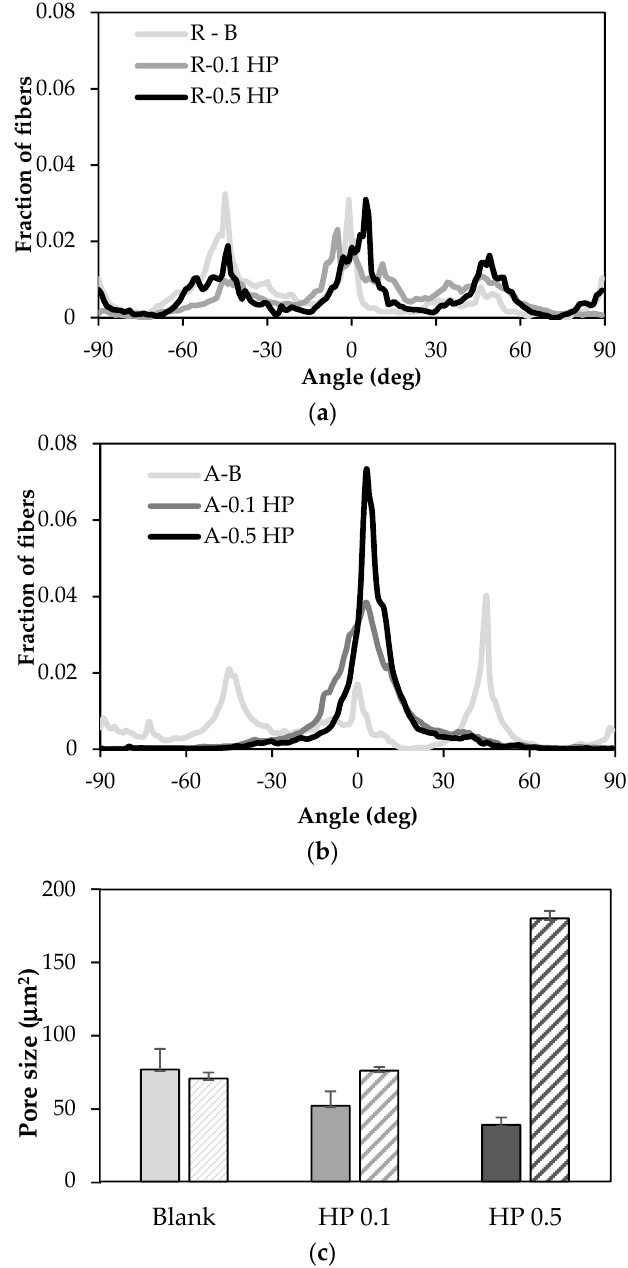
Figure 3. Degree of fiber orientation of blank (light grey), 0.1% HP (grey), and 0.5% HP (dark grey) scaffolds in the random ( a ) and aligned tubular ( b ) structure. The mean pore area ( μ m 2 ) is reported in subfigure ( c ) (full color: random structure; shaded: aligned tubular). ANOVA one − way; Scheffé test ( p ≤ 0.05): R − B vs. R − 0.5% HP; A − B vs. A − 0.5% HP; A − 0.1% HP vs. A − 0.5% HP; R − 0.5% HP vs. A − 0.5% HP (mean value ± s.d.; n = 10).